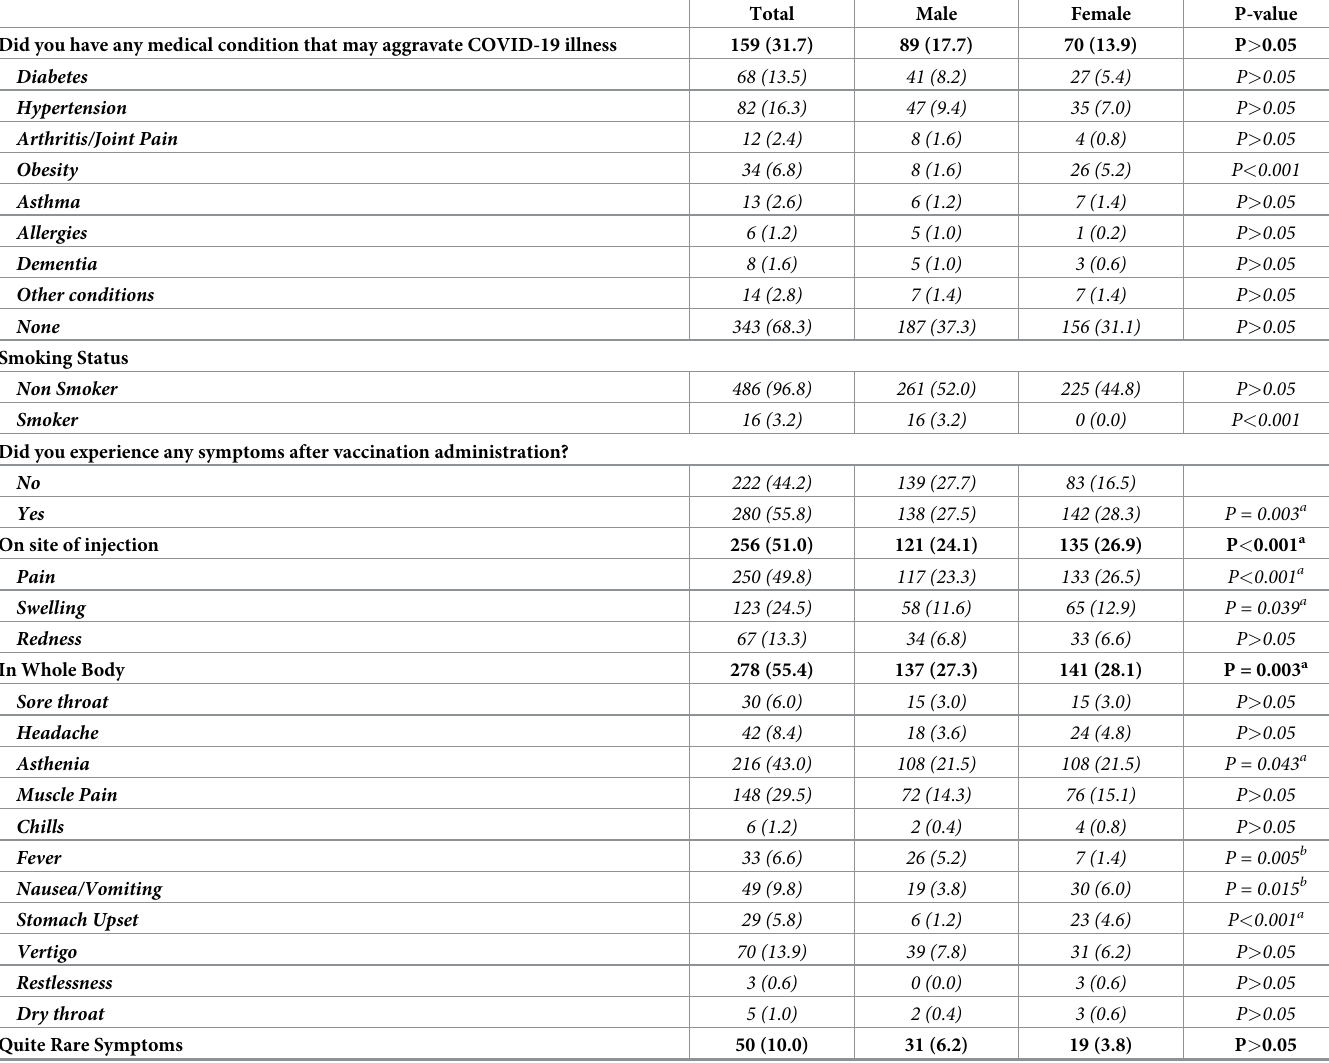
Table 2. Presence of comorbidities, signs, and symptoms associated with vaccine